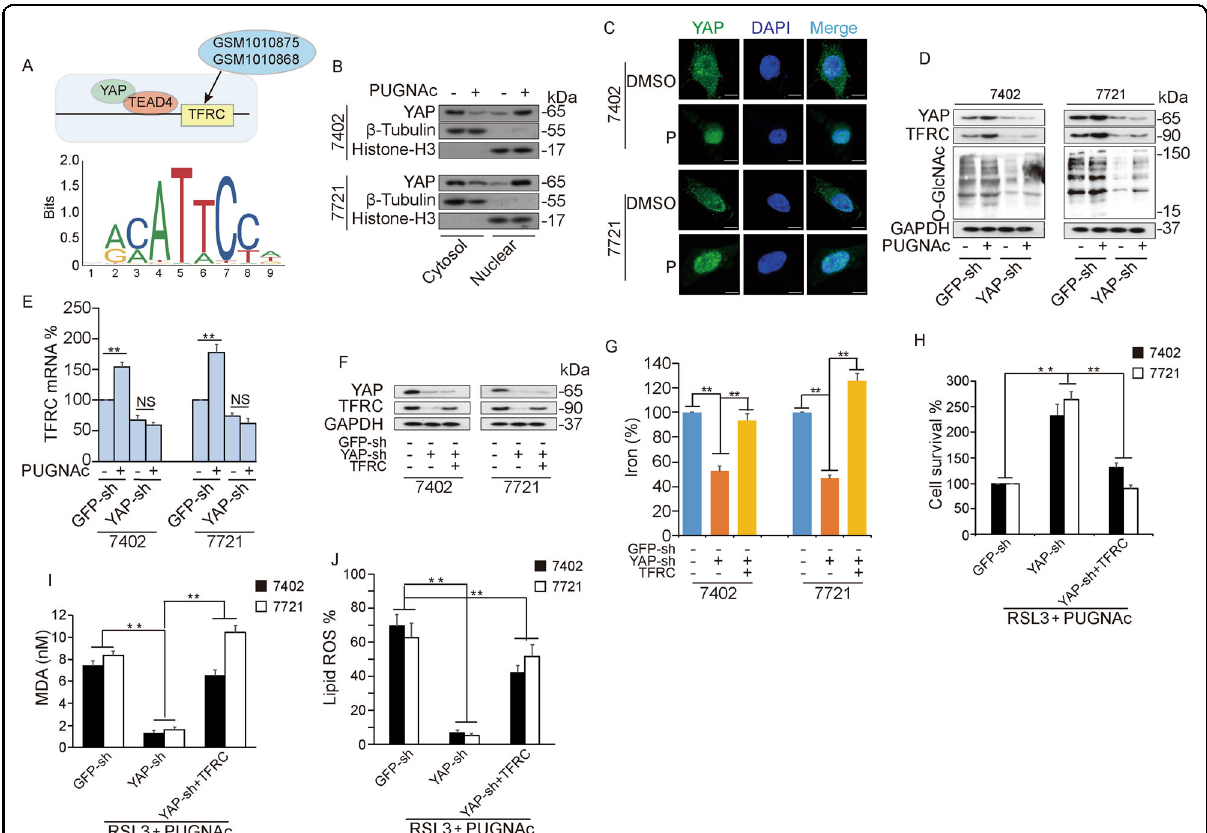
Fig. 4 YAP enhances ferroptosis sensitivity by targeting TFRC. A Bioinformatics analysis of ChIP-seq data acquired from public datasets GSM1010875 and GSM1010868. B Cytosolic and nuclear fractionation experiments in Bel-7402 and SMMC-7721 cells with or without PUGNAc treatment. YAP was detected using WB. C The subcellular localization of YAP was shown using an IF assay in Bel-7402 and SMMC-7721 cells with or without PUGNAc treatment. D and E Expression of YAP, expression of TFRC, and global O-GlcNAcylation were detected by WB ( D ), and the transcription levels of TFRC were measured by qPCR ( E ) in PUGNAc-treated control and YAP knockdown Bel-7402 and SMMC-7721 cells. F and G The protein expression levels of YAP and TFRC ( F ) and the iron level ( G ) were determined in Bel-7402 and SMMC-7721 cells with simultaneous knockdown of YAP and overexpression of TFRC. H – J Ferroptotic events were evaluated in control Bel-7402 and SMMC-7721 cells and Bel-7402 and SMMC-7721 cells with simultaneous YAP knockdown and TFRC overexpression after RSL3 and PUGNAc pretreatment: cell death ( H ), lipid ROS production ( I ), and MDA production ( J